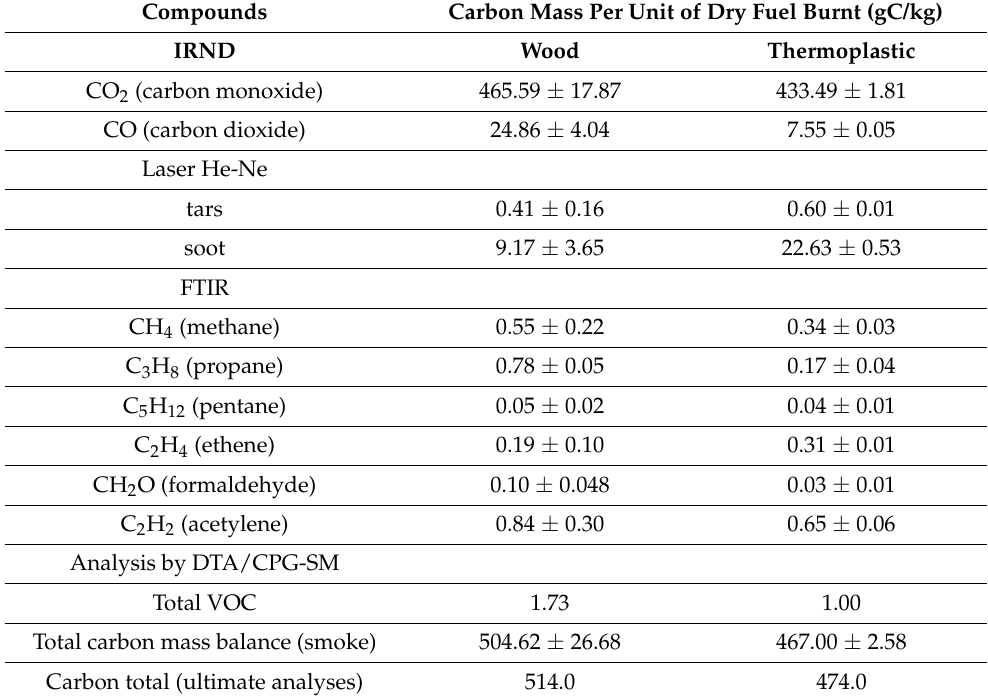
Table 6. EF for VOCs and SVOCs of wood